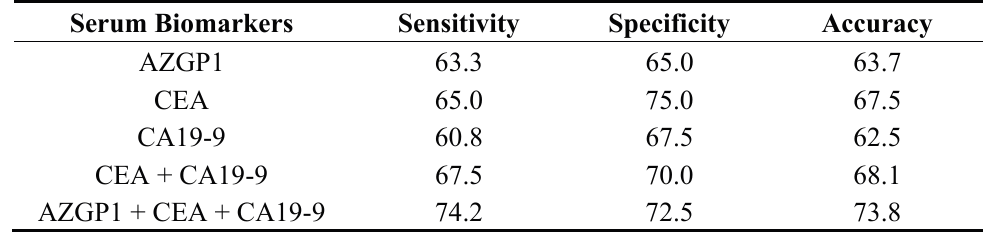
Table 2. Validating the diagnostic value of AZGP1, CEA and CA19-9 and the combination by leave-one-out